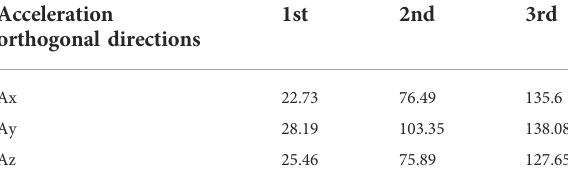
TABLE 1 Railcar ’ s natural frequencies